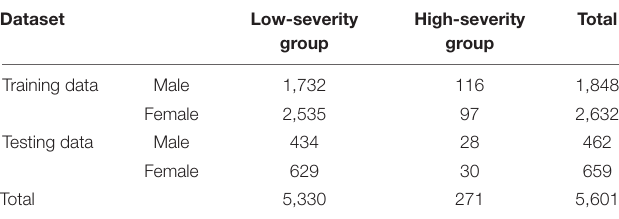
TABLE 2 | Number of data groups for training and testing based on gender and severity.